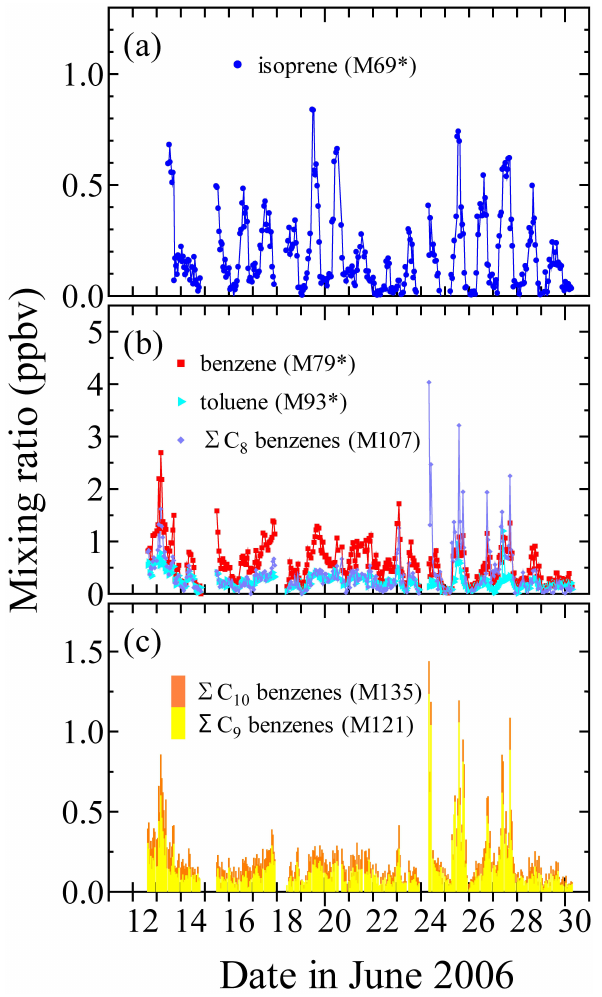
Fig. 4. Temporal variations of mixing ratios for hydrocarbons: (a) isoprene and (b) and (c) aromatics. Hourly averaged PTR-MS data are shown. Asterisks indicate mixing ratios corrected by GC-FID data (see